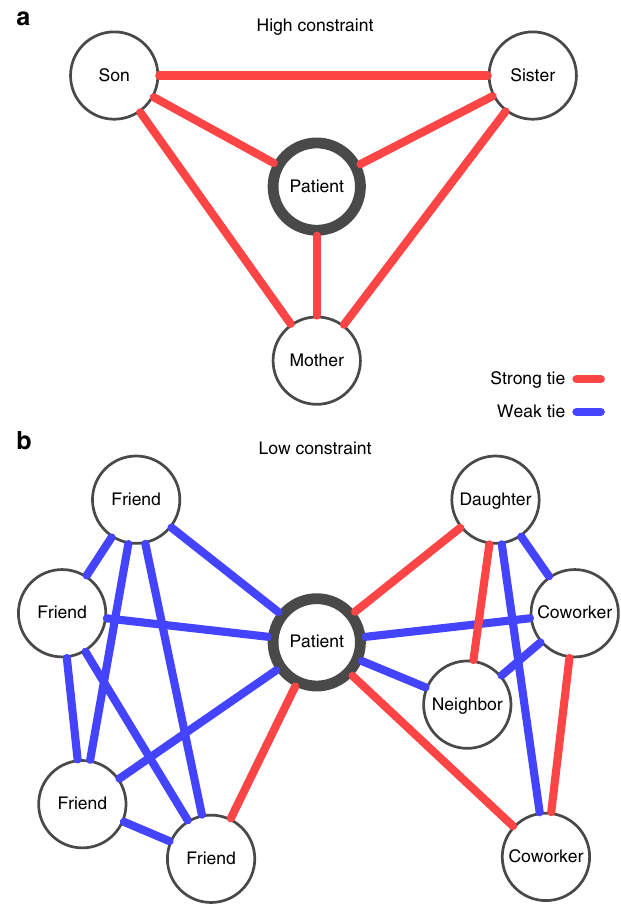
Fig. 1 Personal networks of two patients with ischemic stroke. Each patient is connected to social contacts by red lines indicating strong or especially close relationships and blue lines indicating weak or less close relationships. No ties between persons means those individuals do not know each